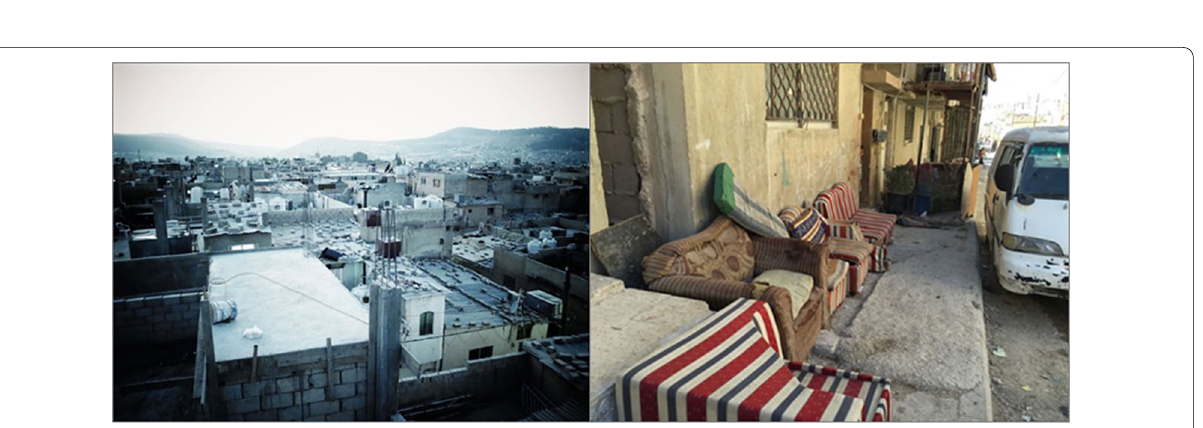
Fig. 11 Refugee camps as socio-cultural spaces and places (Maqusi